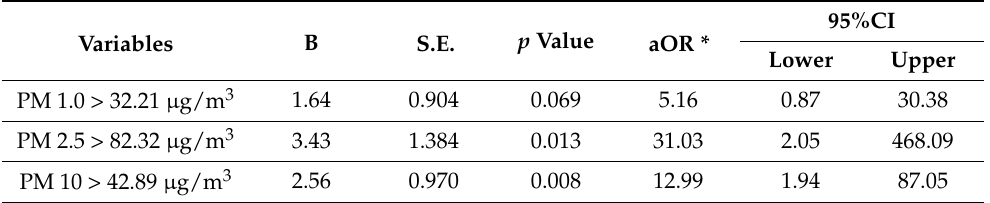
Table 6. Multivariate logistic regression analysis of PM